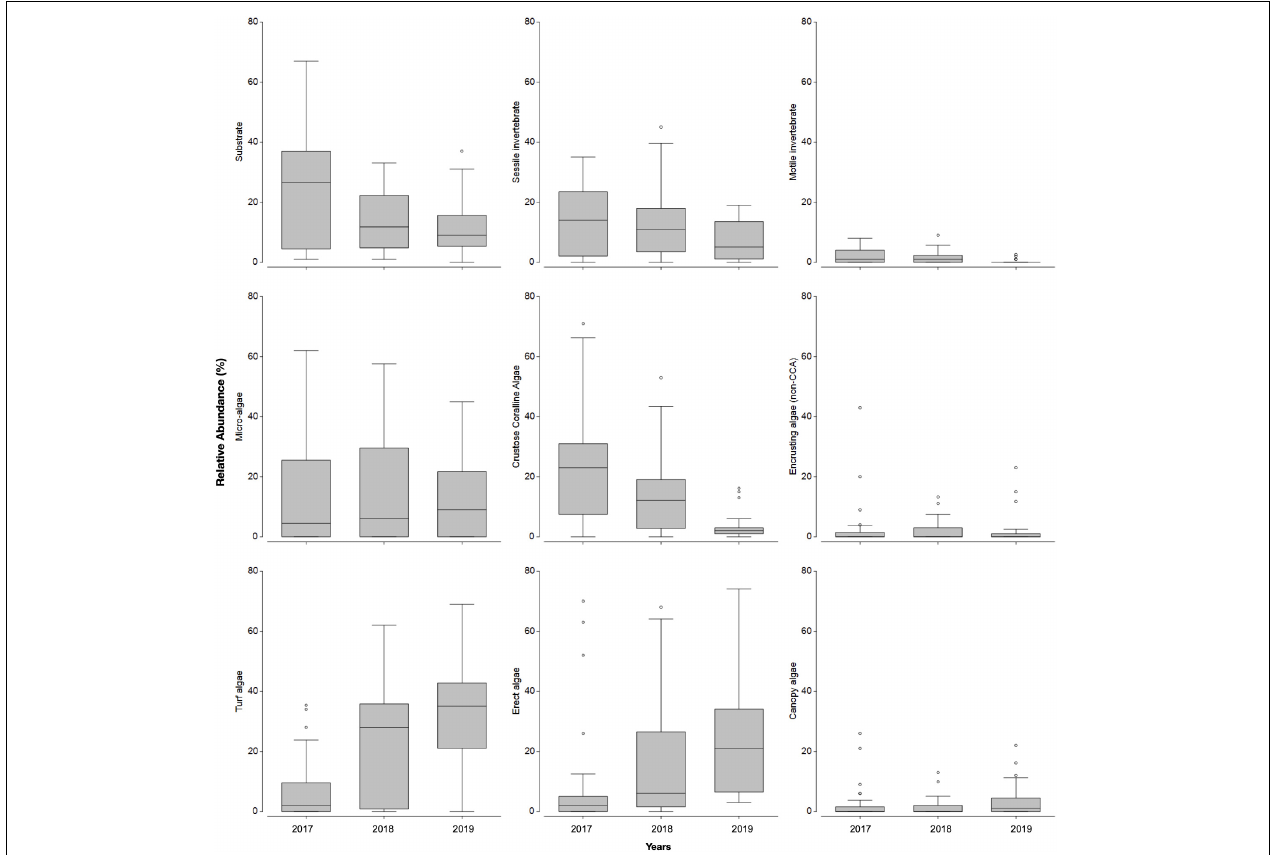
FIGURE 2 | Sessile functional group average relative abundance (%) in each of the three considered years (2017, 2018, 2019); boxplot with first quartile, median and third quartile, minimum and maximum as whiskers and points as outliers.